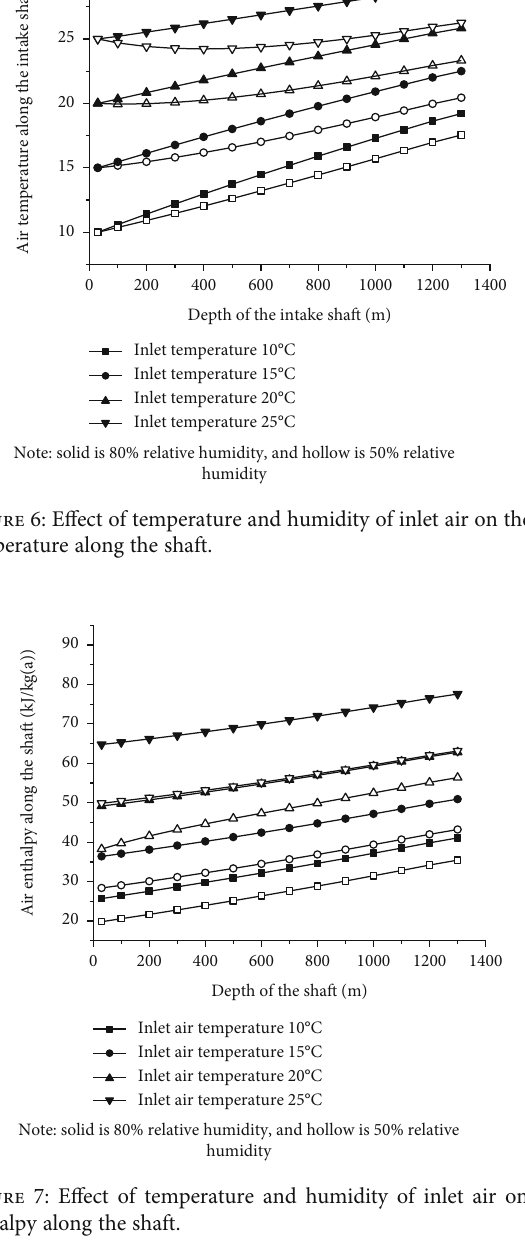
Figure 7: E ff ect of temperature and humidity of inlet air on air enthalpy along the shaft.